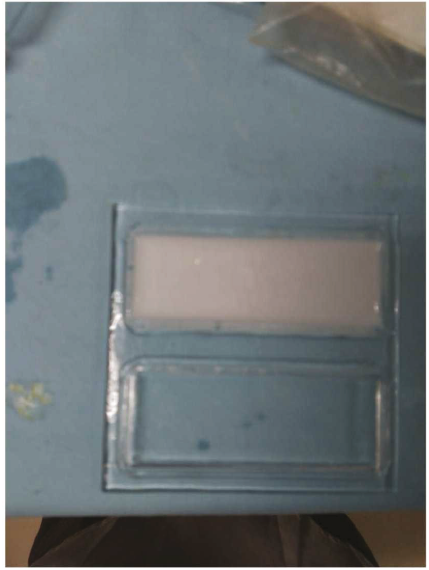
Figure 4: The gel after polymerization under a UV lamp.